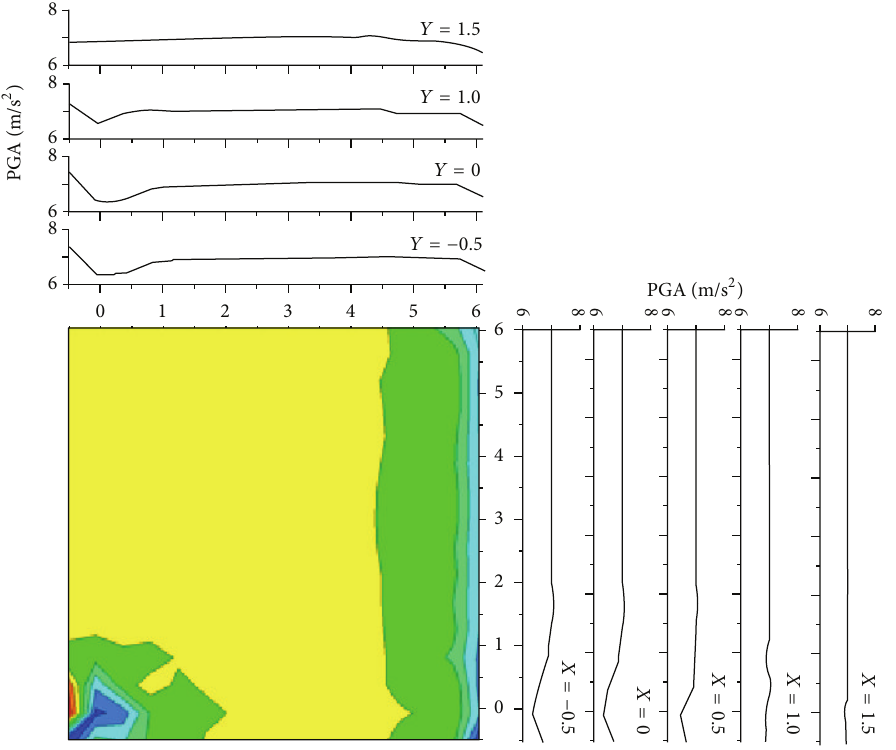
Figure 20: Peak ground acceleration distribution of URBAN2-2 with respect to nondimensional spatial coordinates (1/4 FE model, 𝐷 = 1.25 , El Centro, 𝑆𝑋 . The structure location is (0,0) . The urban nondimensional width is 2.0; the nondimensional effective width of the structural group parallel to the excitation is 5.0; the nondimensional effective width of the structural group perpendicular to the excitation is